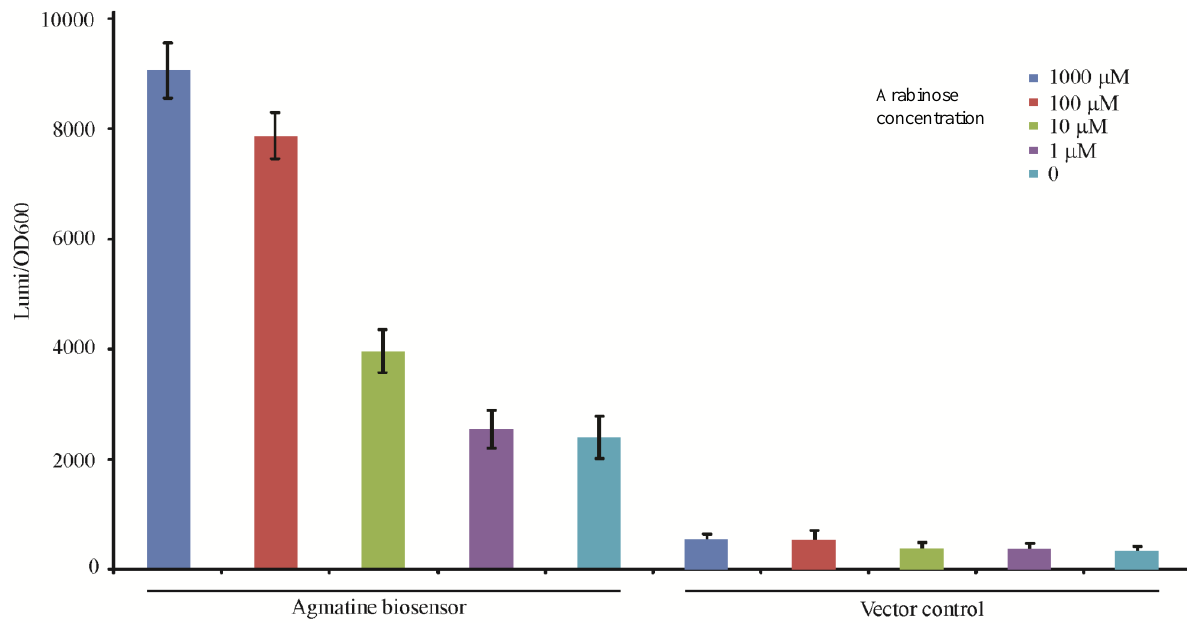
Figure 6. Monitoring arginine decarboxylase production through agmatine detection. The gene for arginine decarboxylase in P. aeruginosa ( speA ) was cloned without a promoter into the pBAD plasmid which uses a titratable arabinose promoter to induce cloned gene products. Each well contained 1 × 10 6 CFU of the SpeA expressing E. coli strain and the agmatine biosensor or its vector control as described for Figure 3. The x-axis indicates which variant of the reporter strain is present and the concentration of arabinose in each culture starting at time 0. Each well also contained 1 mM arginine as a substrate for the reaction. The y-axis represents the relative luminescence/OD 600 of the well at 10 h of growth. Error bars are SEM of three